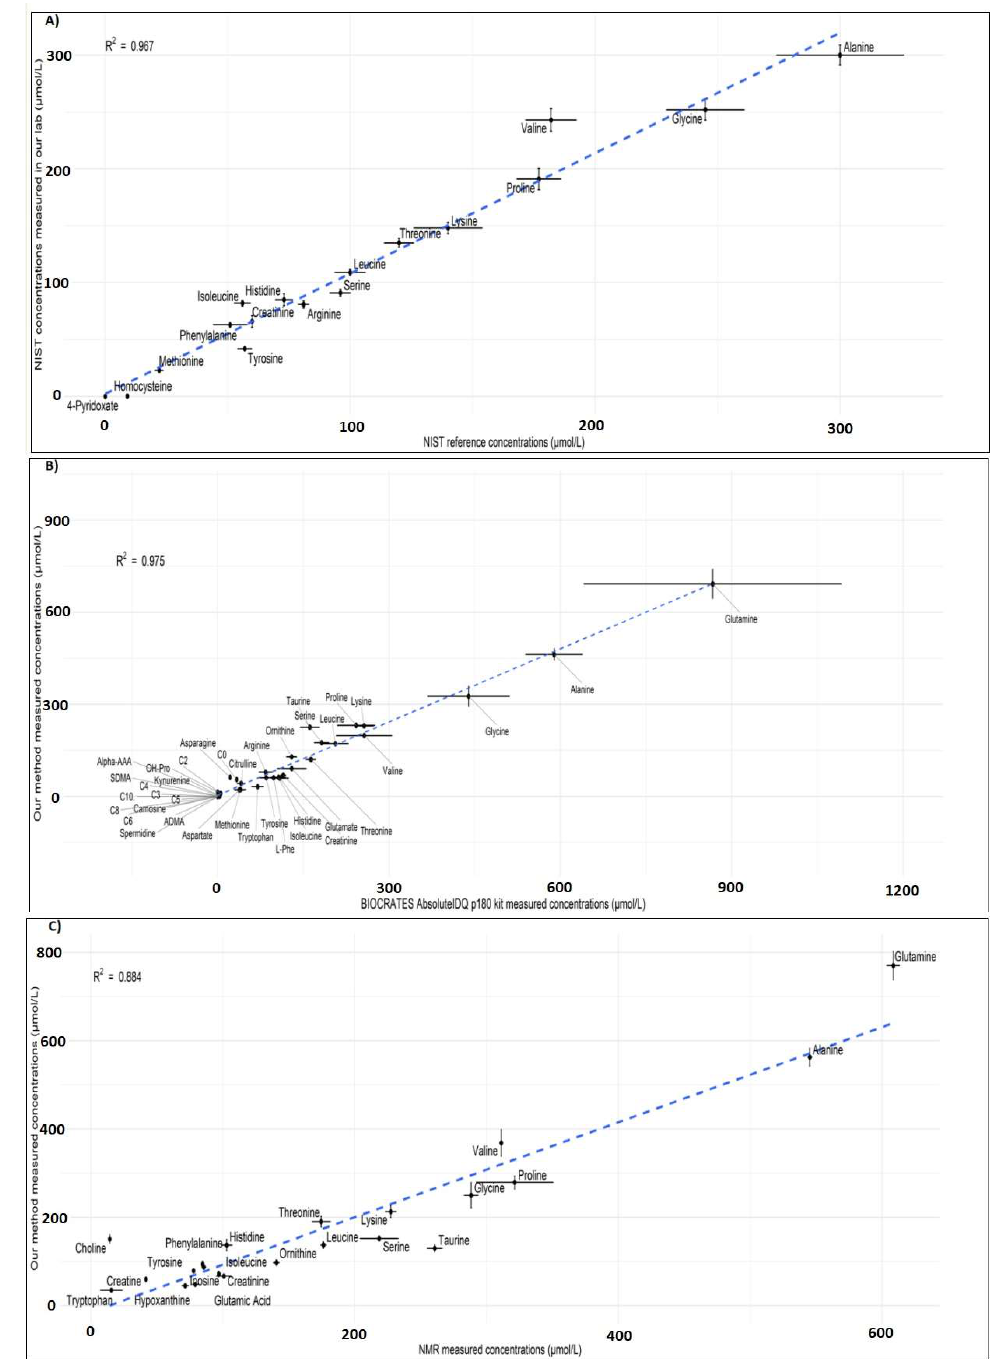
Figure 9. ( A ) Comparison of metabolite concentration reference values given in the NIST SRM 1950 plasma against our method. Comparison of metabolite concentrations in our QC samples measured between our method and ( B ) BIOCRATES AbsoluteIDQ p180 kit, and ( C ) nuclear magnetic resonance (NMR) analyses. Error bars represent 95% confidence intervals.